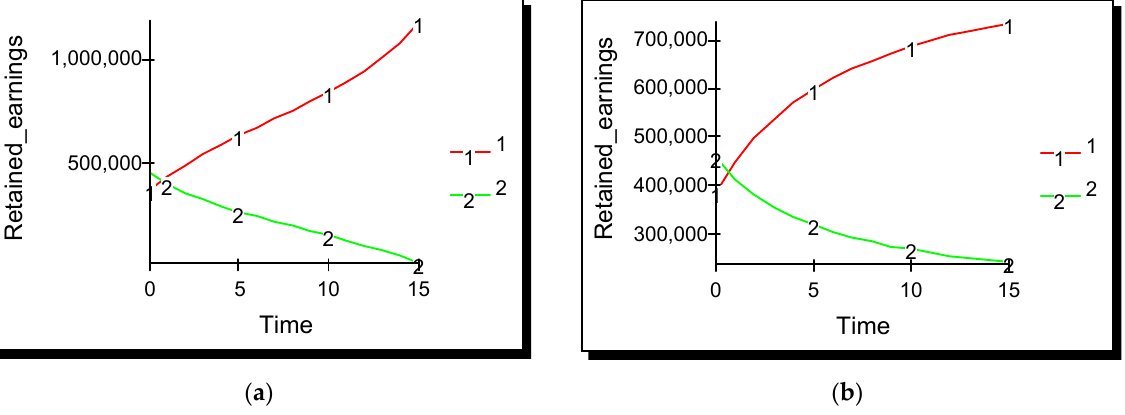
Figure 11. Unilateral perfectly predatory advertising. ( a ) Advertising effectiveness: φ 1 = 0.0000075; φ 2 = 0; advertising interaction: ρ = − 1. ( b ) Advertising effectiveness: φ 1 = 0.0000070; φ 2 = 0; advertising interaction: ρ = − 1.